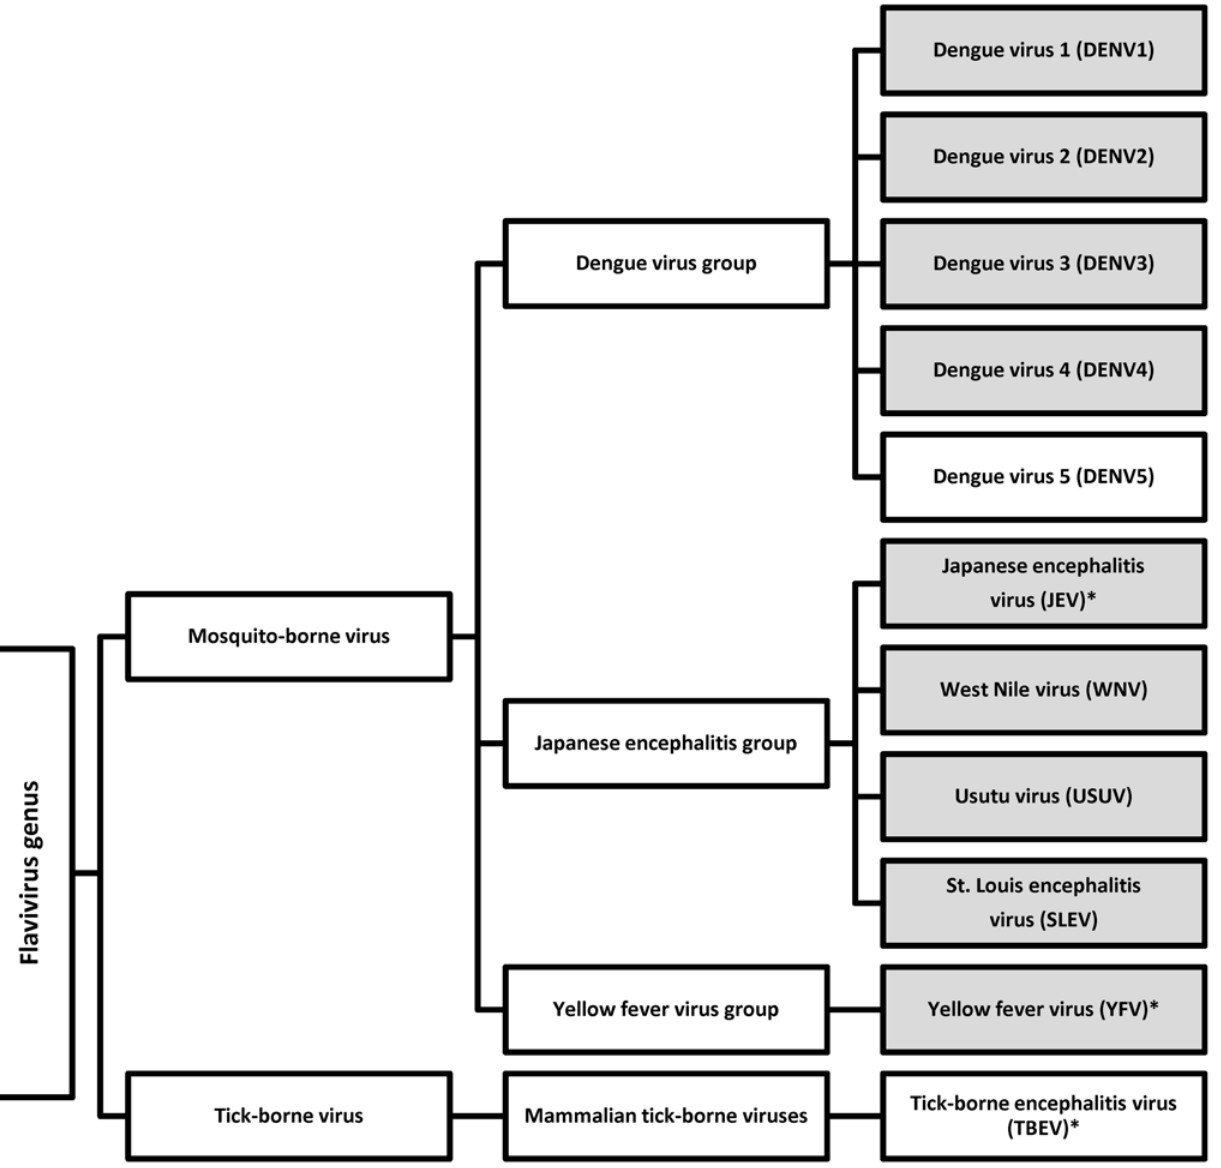
Fig 1. The serogroup classification of the Flavivirus genus of arboviruses used. Shaded boxes indicate antigens and antibodies used in this validation. Viruses with an * indicate that human vaccines are available for this virus.